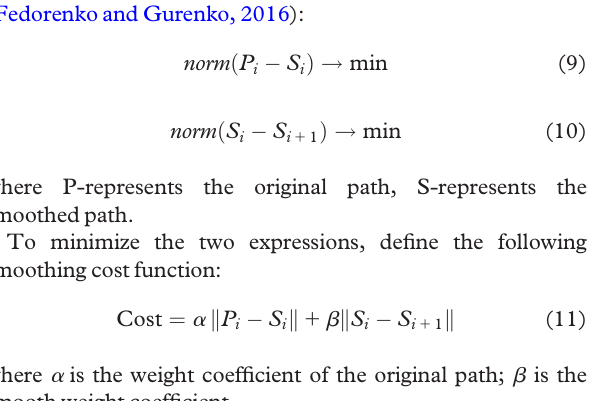
Navigation boundary level